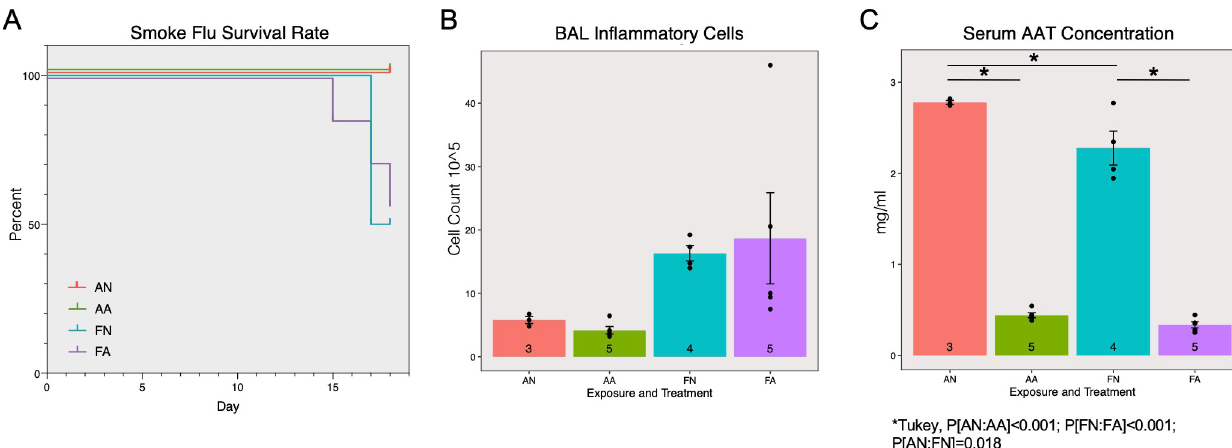
Fig 4. Effects of AAT ASO on smoke and influenza induced COPD exacerbation. The survival rate (A) was only significantly affected by smoke-flu injury but not antisense treatment. Inflammatory cell counts (B) were significantly affected by smoke-flu injury (P[exposure] = 0.025), but not antisense treatment (P[treatment] = 0.810). Serum AAT concentrations were significantly decreased by the antisense oligonucleotide treatment (C, P[treatment] < 0.001).